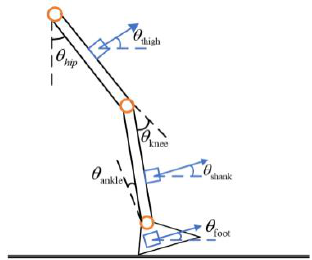
Figure 1. Leg inertial sensor arrangement.